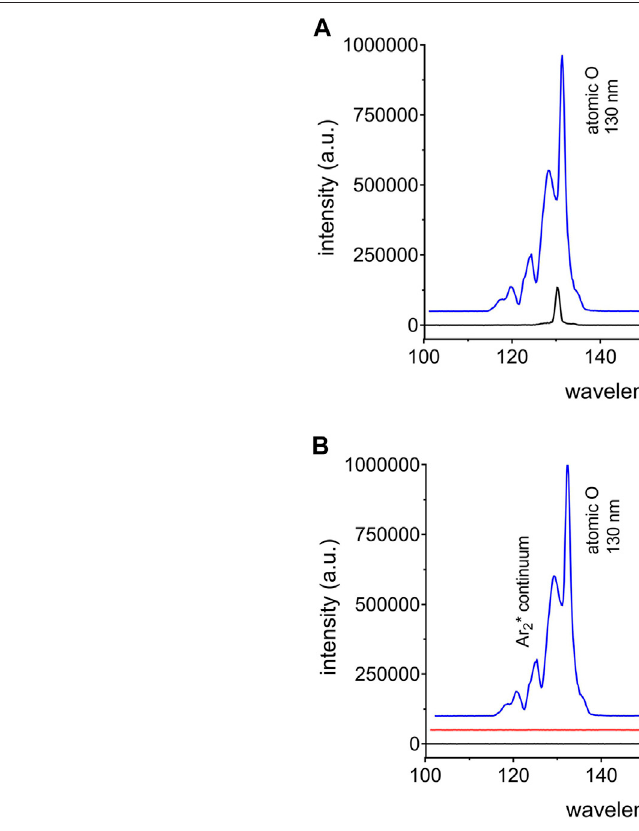
FIGURE4| OESspectraregisteredat9 mmdistancefromkINPen09jetnozzleintherange100 – 200 nm.Argonexcimerlineswereobservedaround120 – 130 nm and180 – 200 nm.Asigni fi cantreductionoftheseemissionslineswasobservedfor0.5%oxygenadmixturetotheargonworkinggas (A) .TheVUVrangewasblockedfor some experiments using borosilicate or suprasil windows (B) , or allowed to access the target (MgF 2 window).